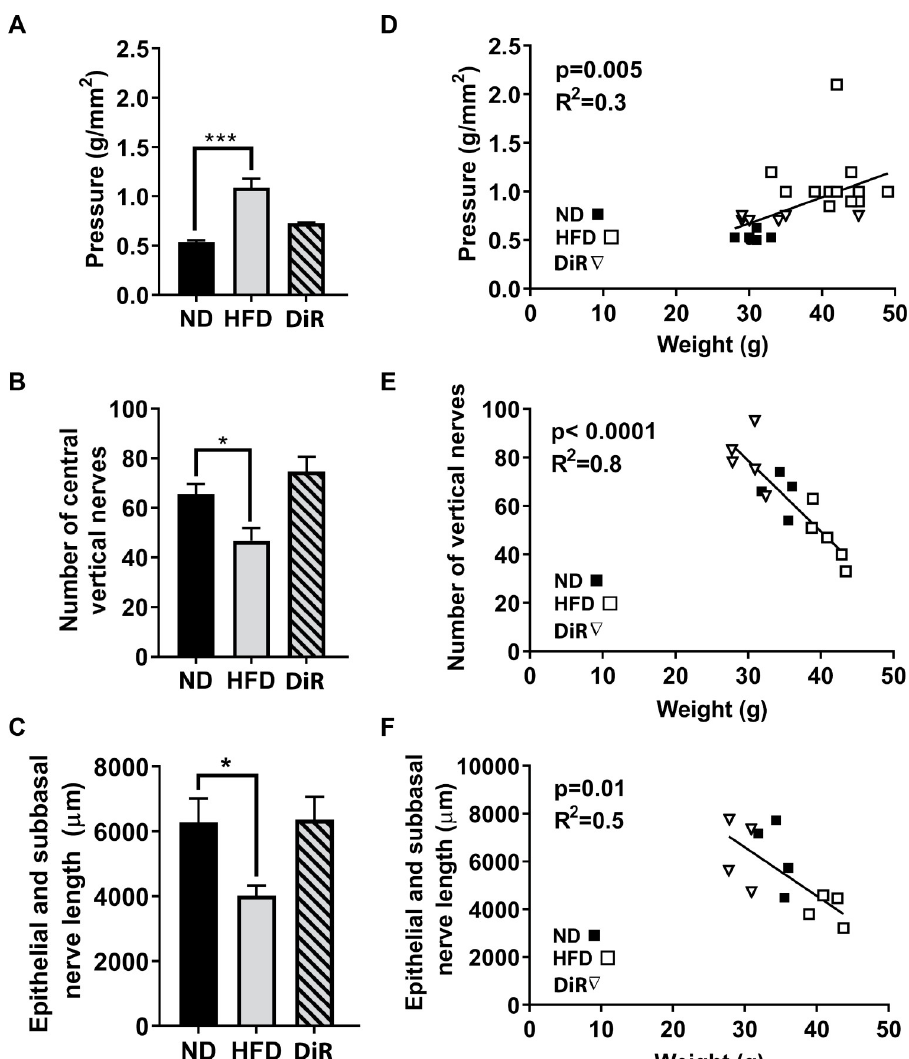
Fig 2. Changes in corneal nerves and sensitivity with diet reversal. C57BL/6 male mice were fed the ND or HFD for 10 weeks, and diet reversal (DiR) mice were fed the HFD for 5 weeks followed by the ND for 5 weeks. (A) Cochet- Bonnett aesthesiometry was used to assess corneal sensitivity to touch (g/mm 2 ) (n = 10 ND, n = 13 HFD, n = 12 DiR). Corneas were analyzed for corneal nerve density, including (B) number of vertical nerves (n = 4 ND, n = 5 HFD, n = 6 DiR) or (C) total length in μ m of epithelial branches and the subbasal plexus (n = 4 per group). Data shown as means ± SEM. � p < 0.05, ��� p < 0.001. Pearson correlations of these measures with body weight for ND, HFD and DiR at 10 weeks are also plotted